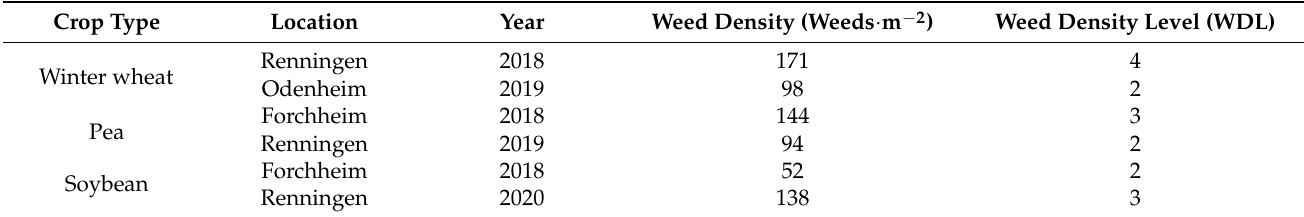
Table 7. Average weed densities and Weed Density Levels (WDL) in untreated control plots (CON) three days after the last treatment. Crop